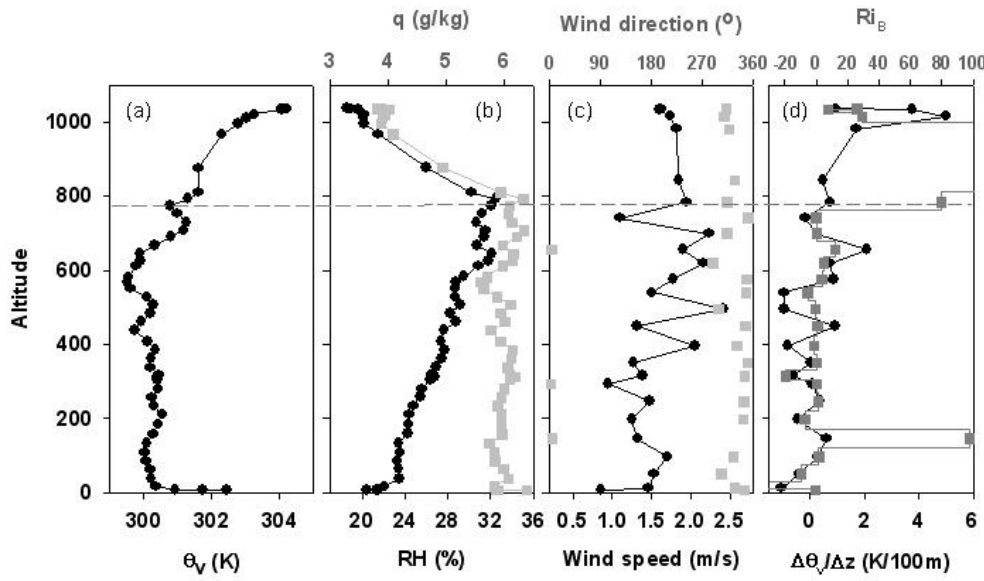
Fig. 1. Vertical profiles of (a) virtual potential temperature ( θ v ) , (b) specific (q) and relative (RH) humidity, (c) wind speed and direction, Figure 1. Vertical profiles of (a) virtual potential temperature (  and (d) vertical gradient of θ v and bulk Richardson number (Ri B ) for 10:23 ∼ 10:51 of 21 August 2007. Data were obtained with balloon tethersonde measurements. Horizontal dashed line represents boundary layer height ( z i ) ( RH ) humidity, (c) wind speed and direction, and (d) vertical gradient of  number ( Ri ) for 10:23~10:51 of 21 August, 2007. Data were obtained with balloon tethersonde B measurements. Horizontal dashed line represents boundary layer height ( z